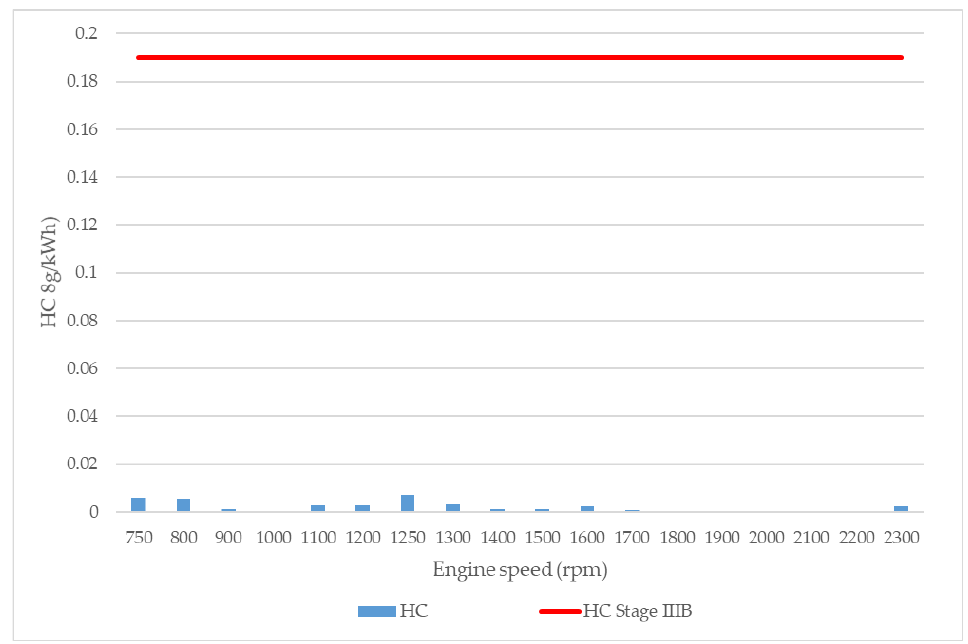
Figure 7. Comparison of HC depending on engine speed with EPA/COM IIIB standard. NO x levels were below the standard limit in the entire engine speed range (Figure 8). The amount of NOx was very close to the limit value at the lowest engine speeds, which is a consequence of the cold start of the engine when the catalyst system has not reached the operating mode.